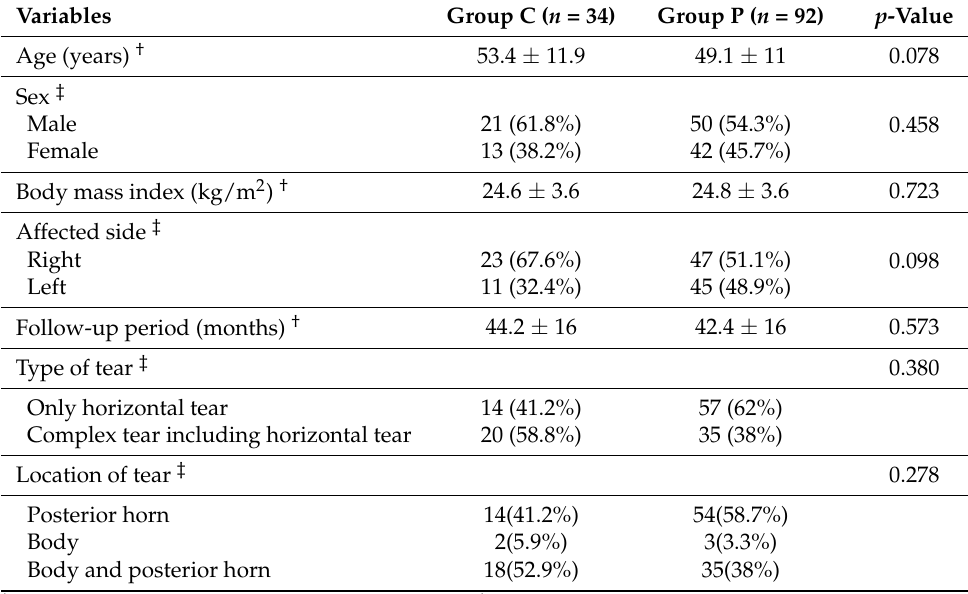
Table 1. Demographic Data of Patients and the Pattern of Meniscus Tear.